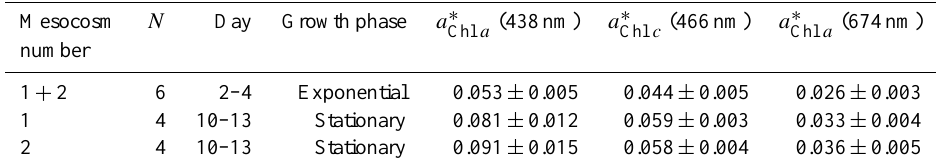
Table 2. Phaeocystis chlorophyll-specific absorption coefficients peaks in m 2 (mgChl) − 1 during exponential and stationary growth. Listed are averages ± 95% confidence intervals.